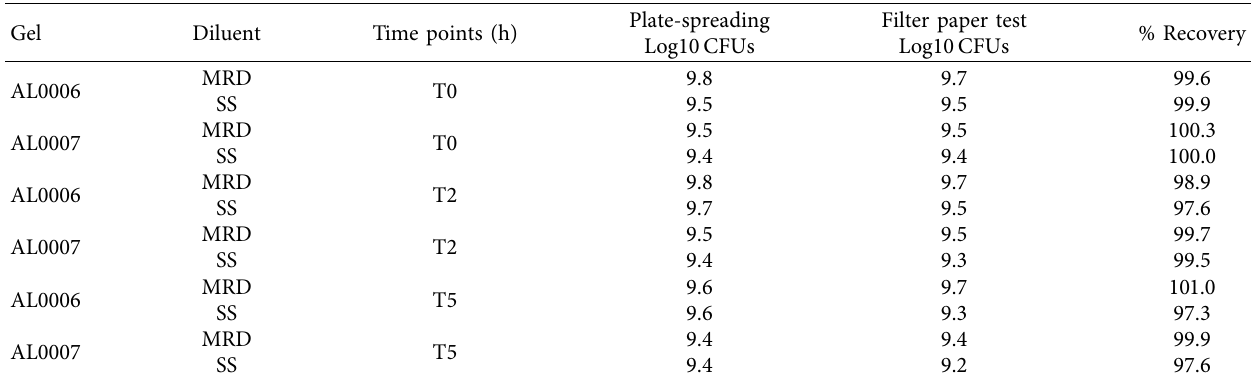
Table 3: Comparison of the results obtained with the filter paper test (semiquantitative assessment) and the plate-spreading on the agar test (Quantitative assessment) to estimate the release of bacteria in two different diluents (MRD or SS), and % recovery. Gel